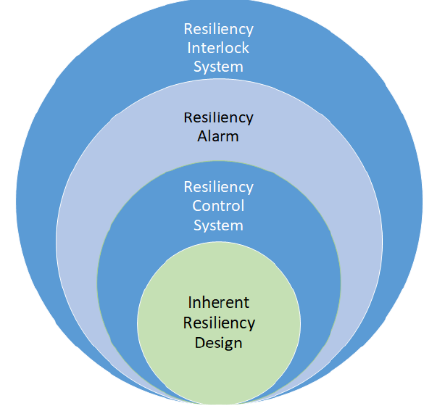
Figure 5. Independent resiliency layers.